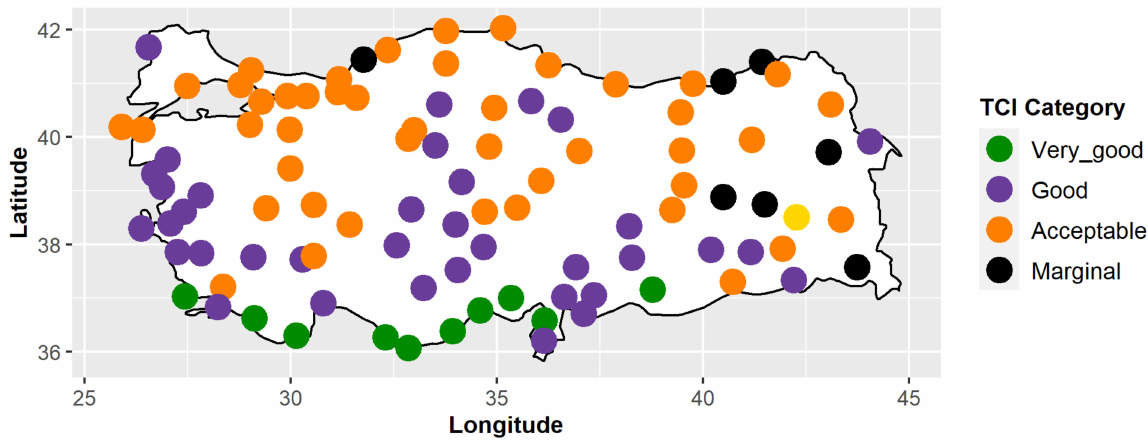
Figure A3. TCI distribution for February.